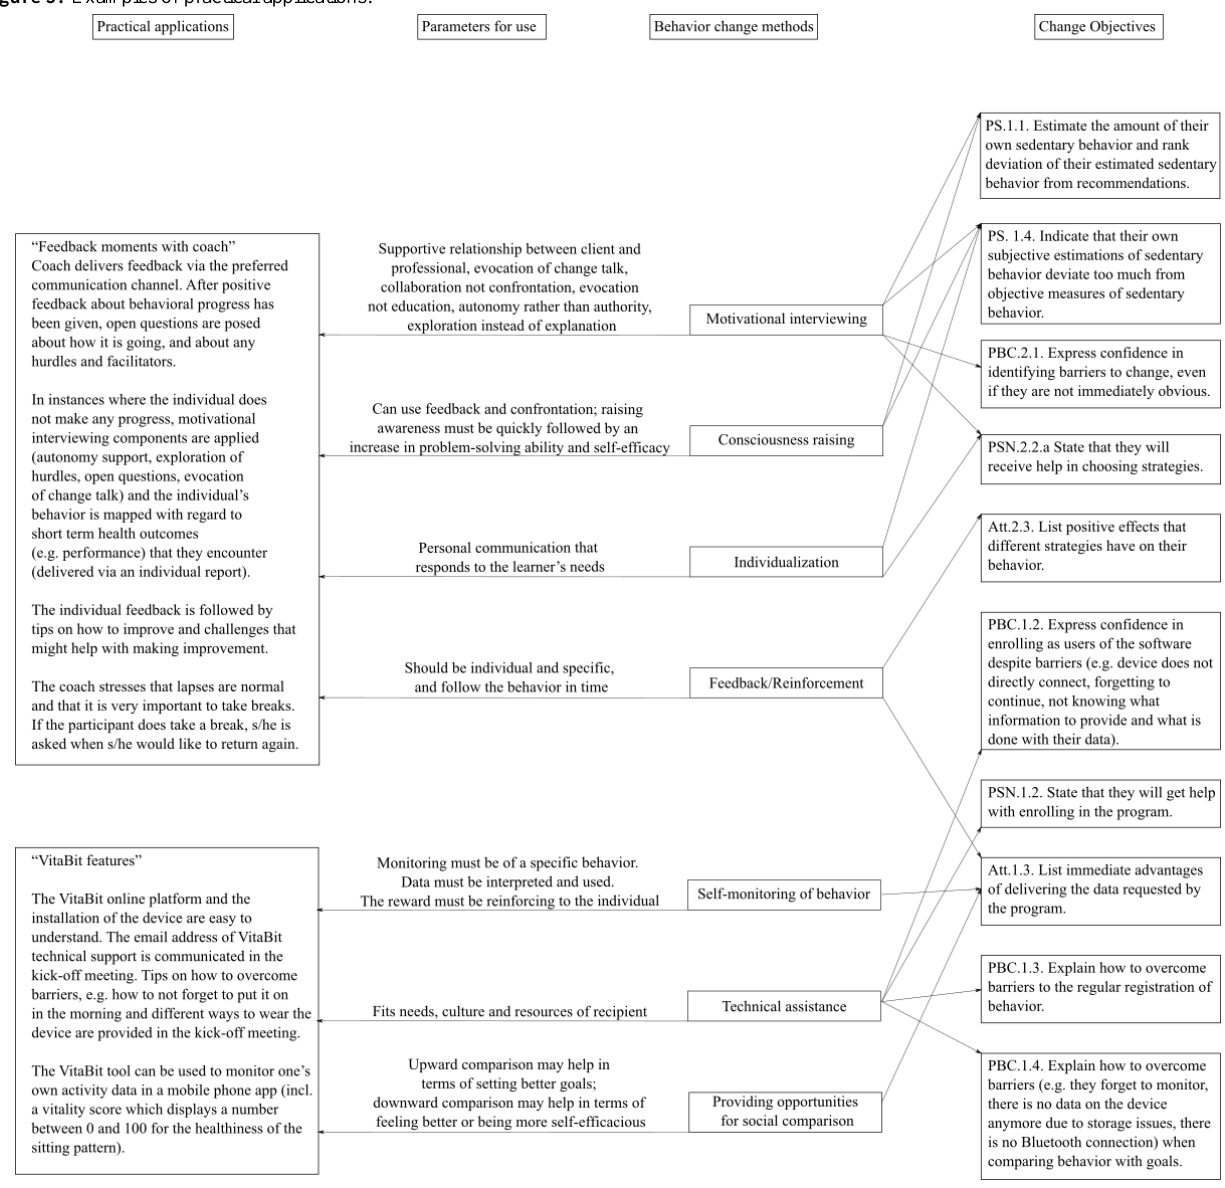
Figure 5. Examples of practical